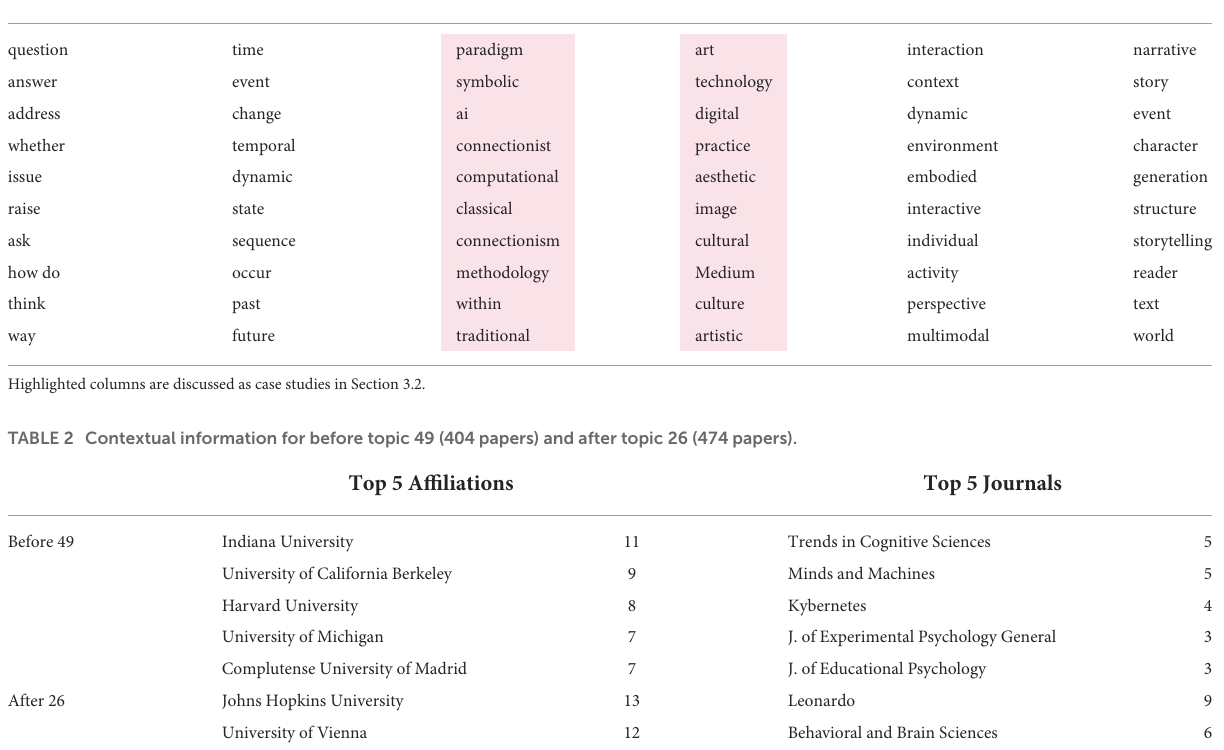
TABLE 1 Top keywords associated with the high entropy topics from Figure 2. Before 34